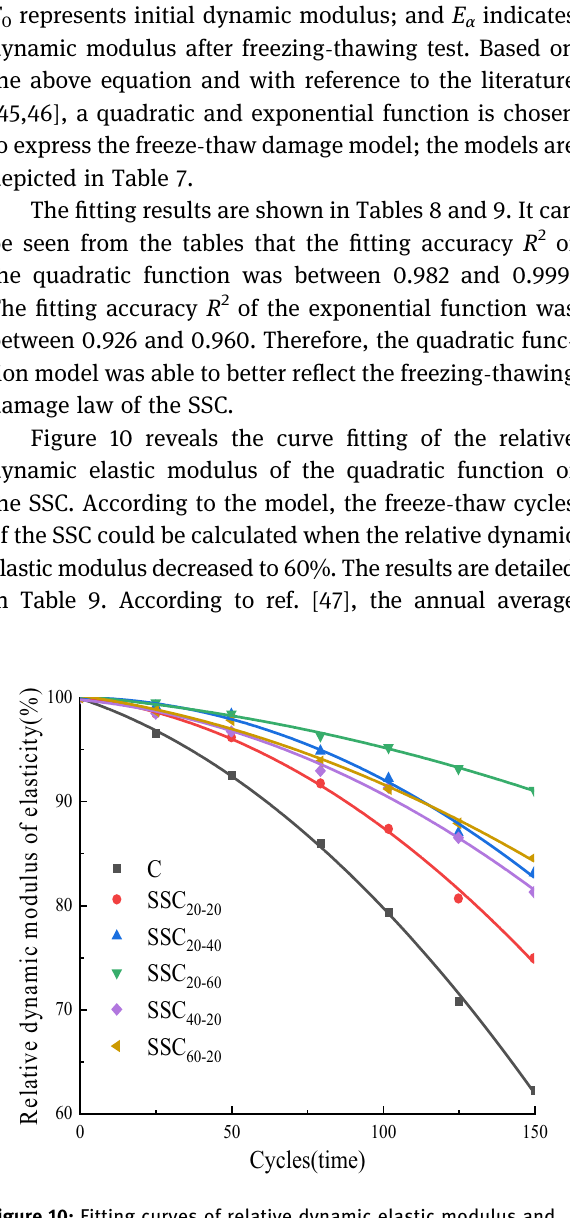
Figure 10: Fitting curves of relative dynamic elastic modulus and freezing - thawing